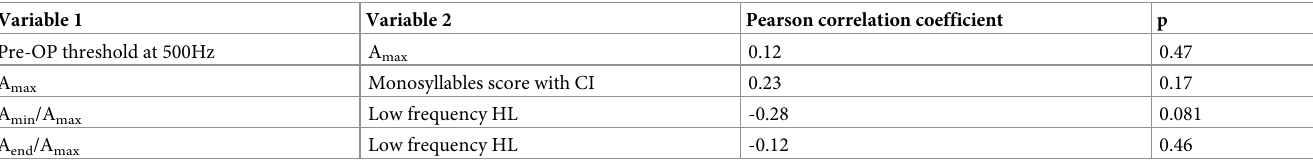
Table 1. Correlation analysis between several intra-operative measures and audiometric/outcome measures. A max is the maximal CM amplitude during insertion. A min is the minimal CM amplitude after A max . A end is the final CM amplitude at the end of insertion. Low frequency HL is the average (125 Hz– 1.5 kHz) increase in thresholds 4 weeks after surgery compared to